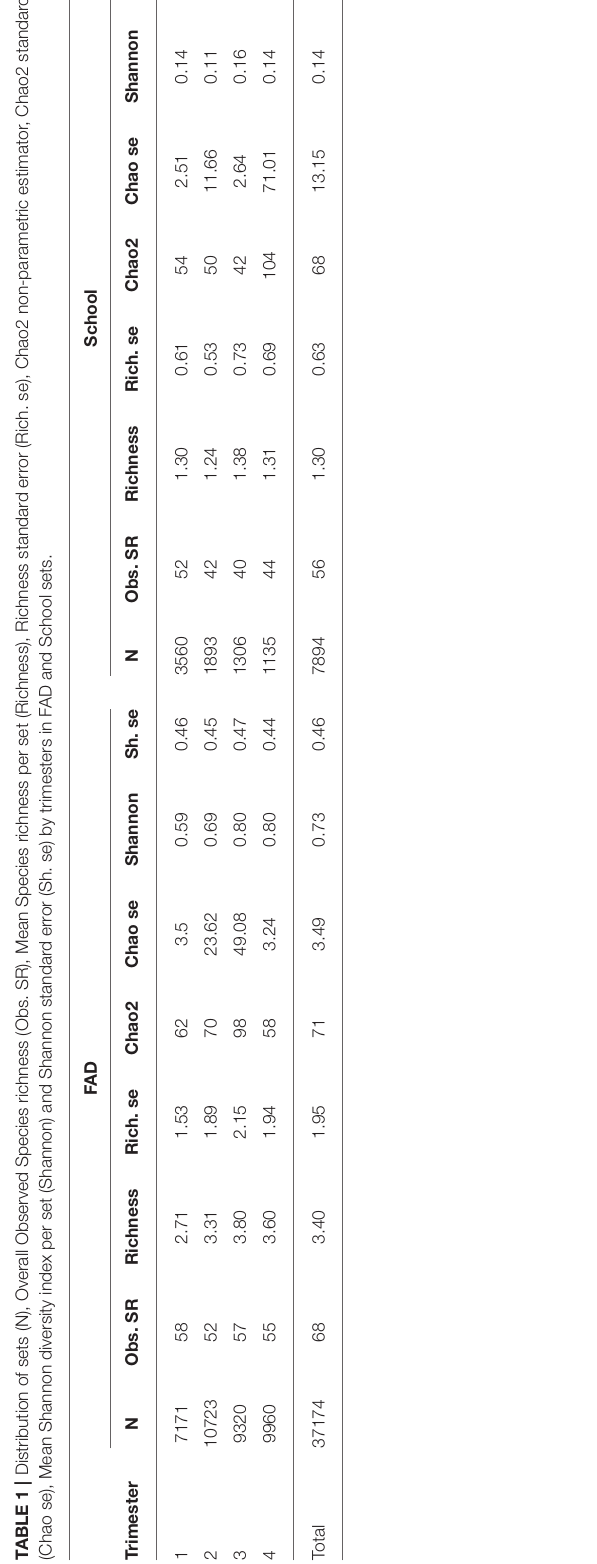
FIGURE 1 | Distribution of sets with presence of bycatch in FAD and School fishing mode between 2005 and 2011.